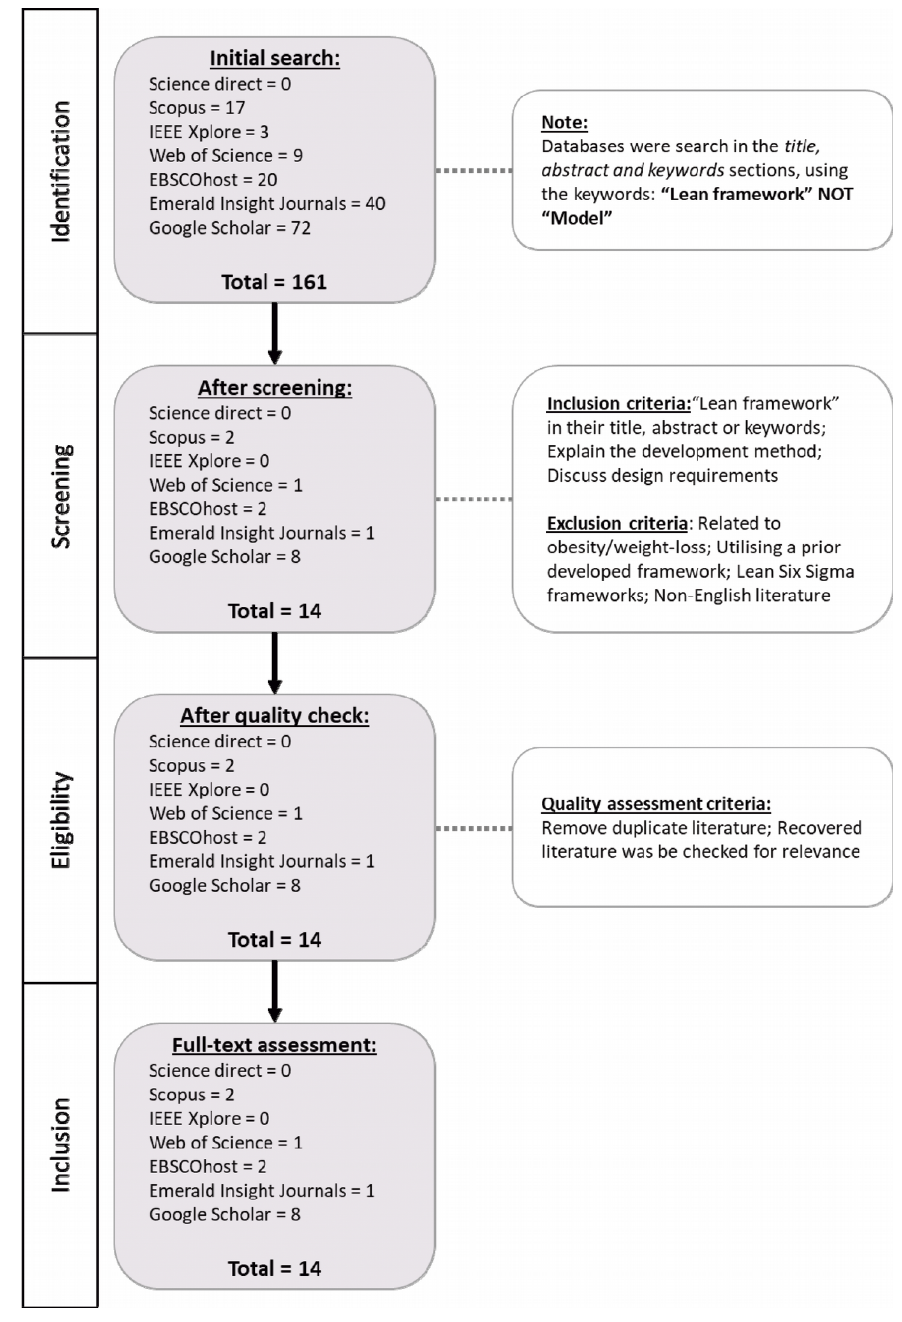
Figure 1. Literature selection